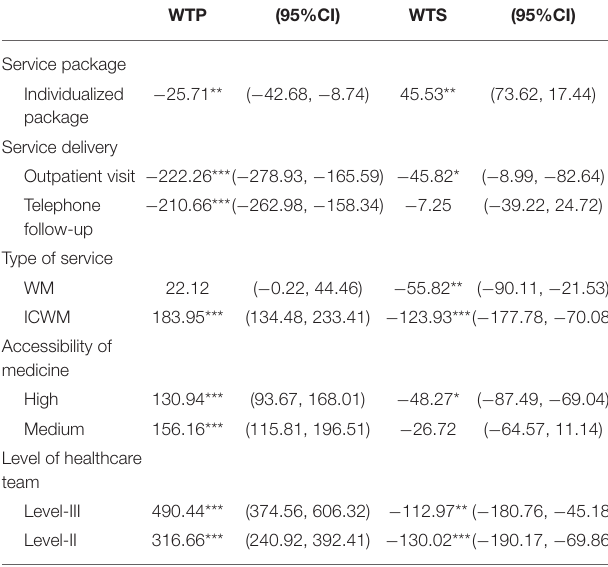
FIGURE 1 | RI of the FDCS attributes for residents and healthcare providers. RI, relative importance; FDCS, family doctor contract service. TABLE 5 | WTP of residents and WTS of healthcare providers (yuan U